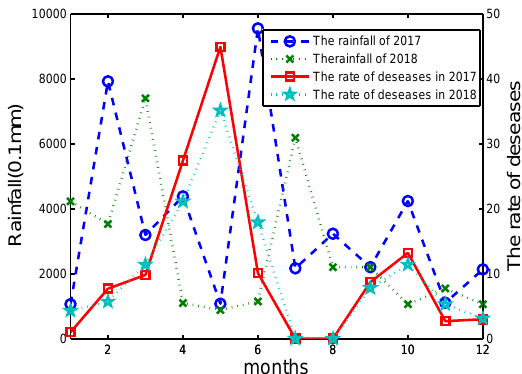
Figure 14. The rainfall and wheat incidence in Yangtze River Zone of China from 2017 to 2018